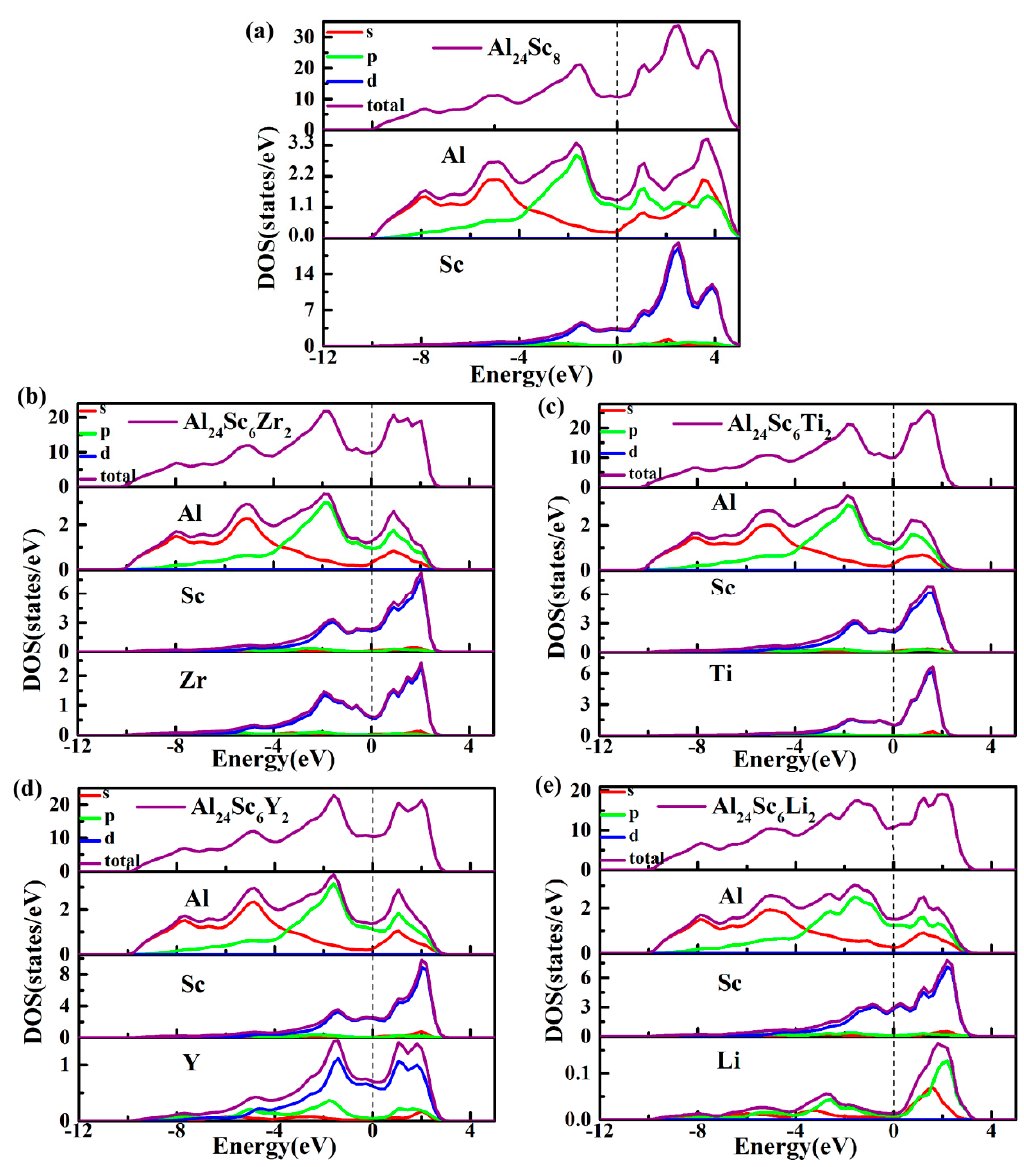
Figure 7. Total density of states (TDOSs) and Partial density of states (PDOSs) of ( a ) Al 3 Sc and ( b – e ) Al 24 Sc 6 M 2 (M = Zr, Ti, Y, and Li) alloys. TDOSs for different structures and different elements are represented by purple lines. PDOSs for different orbitals are denoted by s in red, p in green and d in blue.